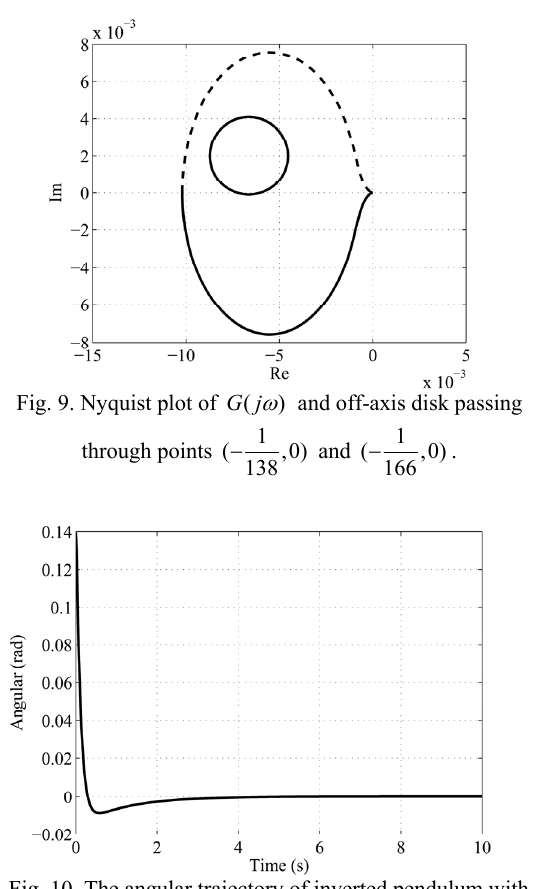
Fig. 10. The angular trajectory of inverted pendulum with initial angle of 8 0.1396 rad ≈ (cid:68)